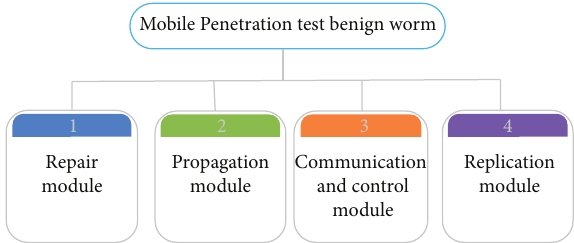
Figure 6: Composition of a penetration testing benign worm.